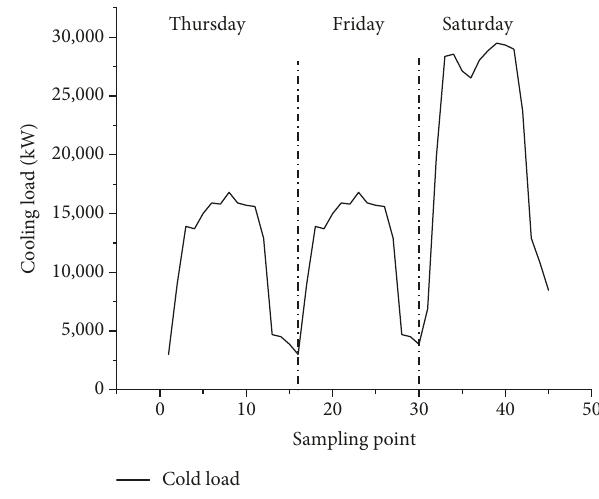
Figure 2: Cooling load variation